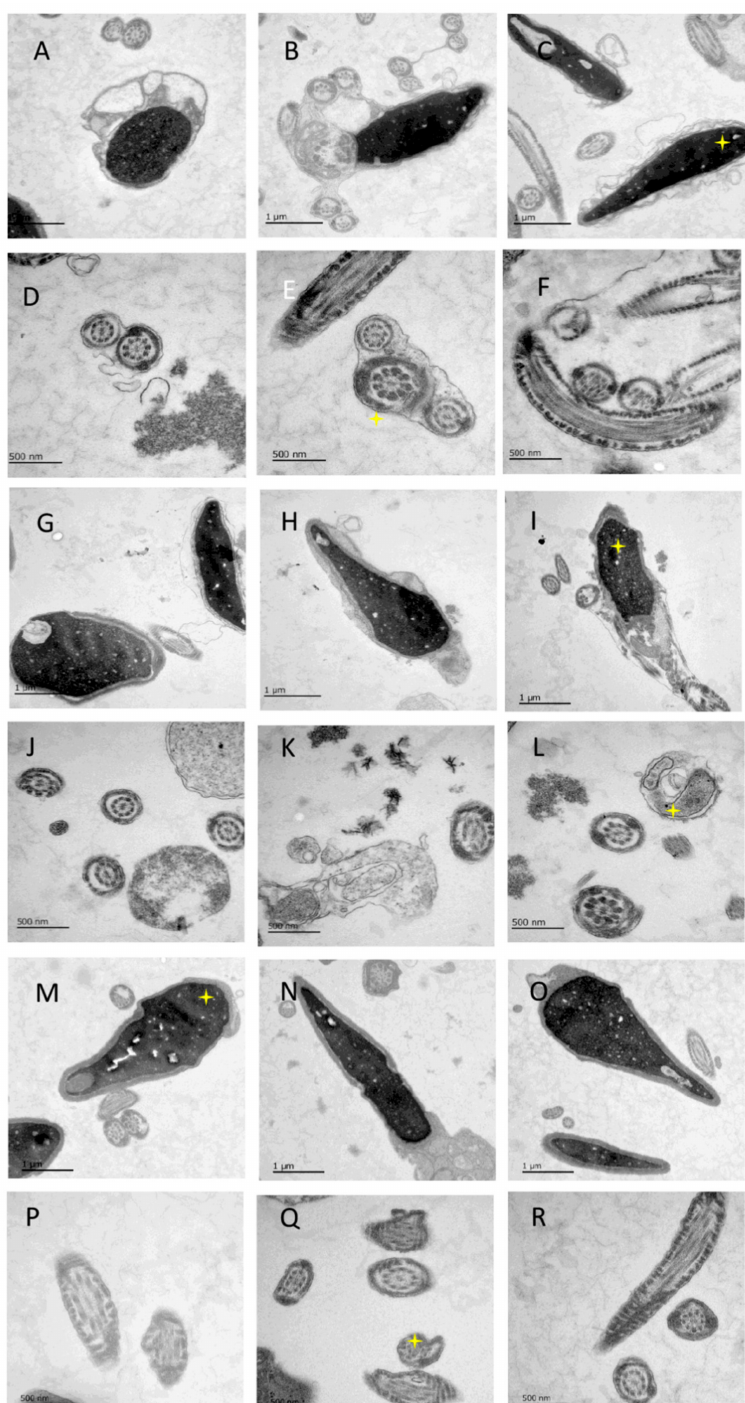
Figure 4. Ultrastructure of spermatozoa heads and mitochondria in fresh, slow-frozen, and vitrified samples. ( A – C ) Spermatozoa in fresh condition with clear edge of head; ( D – F ) normal mitochondria with dense structure in fresh spermatozoa group. ( G – I ) Photos of head in slow-frozen spermatozoa with swelling, disintegration, and disruption of plasma membrane of acrosome. ( J – L ) Photos of slow-frozen spermatozoa with loose mitochondrial structure, widening of mitochondrial cristae, and increased vacuole-like changes. ( M – O ) Photos of vitrified spermatozoa head with clear edge and complete head part. ( P – R ) Pictures of vitrified spermatozoa with dense mitochondrial structure, slightly lighter coloration, and widened mitochondrial